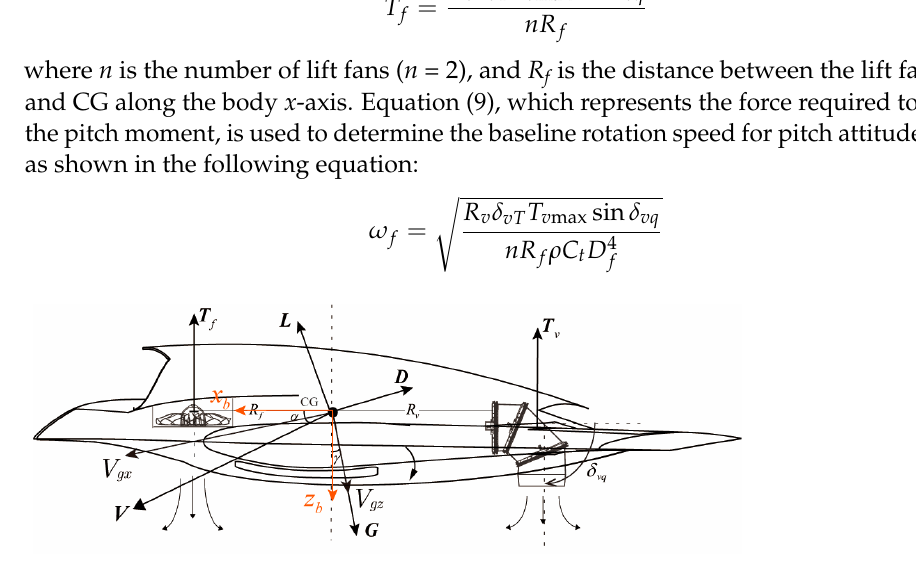
Figure 4. Longitudinal force analysis.